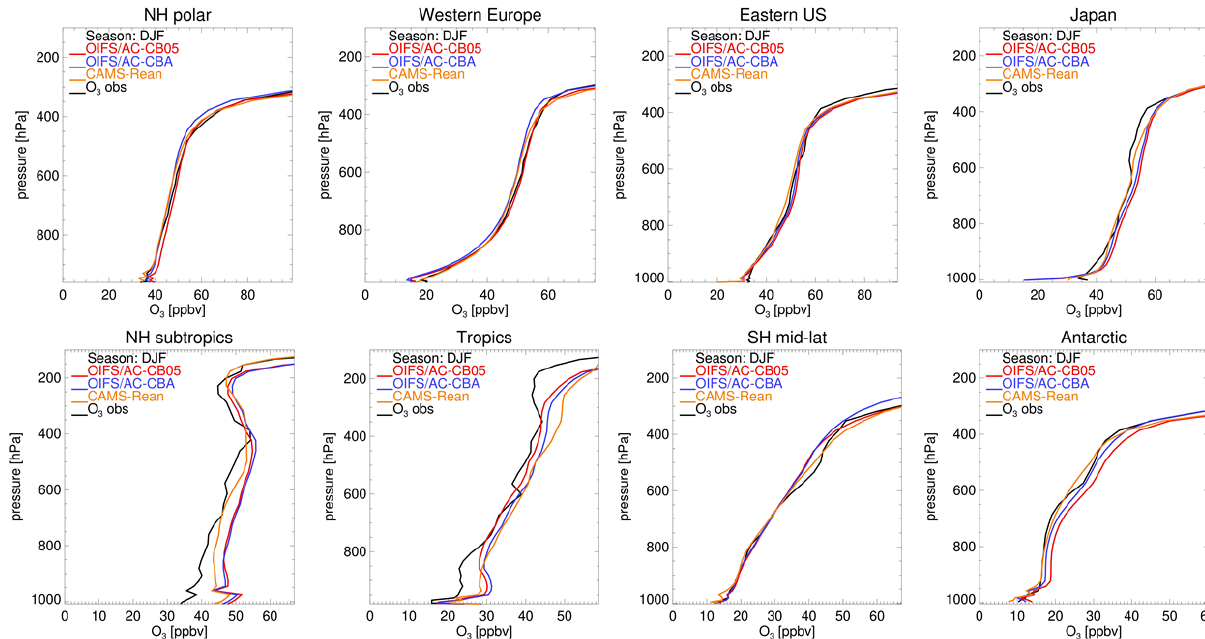
Figure 1. Evaluation of OpenIFS/AC tropospheric O 3 profiles against sondes during December, January, and February (DJF) 2010. For reference, data from the CAMS reanalysis are also provided (orange).